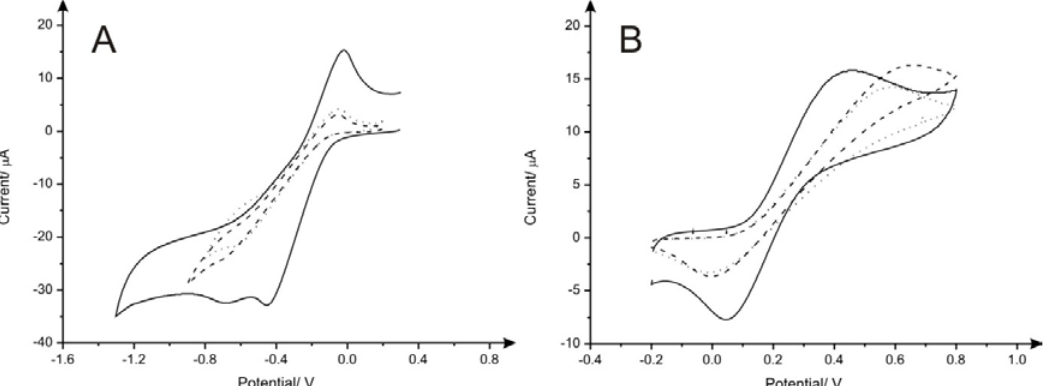
Figure S3. Comparison of cyclic voltammograms recorded for PDEs fabricated using HB pencils from boxes 1, 3 and 5, respectively, in 1 mM hexaammineruthenium(III) chloride ( A ) and 1 mM potassium ferrocyanide(II) ( B ) redox probes/0.1 M KCl. Scan rate: 5 mV·s − 1 . PDE1 (solid line), PDE3 (dashed line) and PDE5 (dotted line).